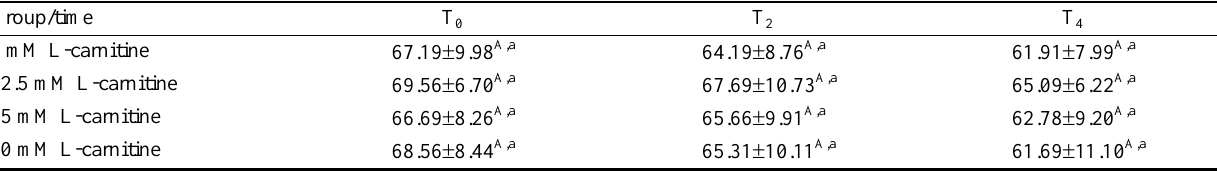
Table 3. Plasma membrane integrity (%) of post-thawed cauda epididymal spermatozoa after thawing for 0 h (T0), 2 h (T2), and 4 h (T4) in each experimental group (mean  SD) Group/time T